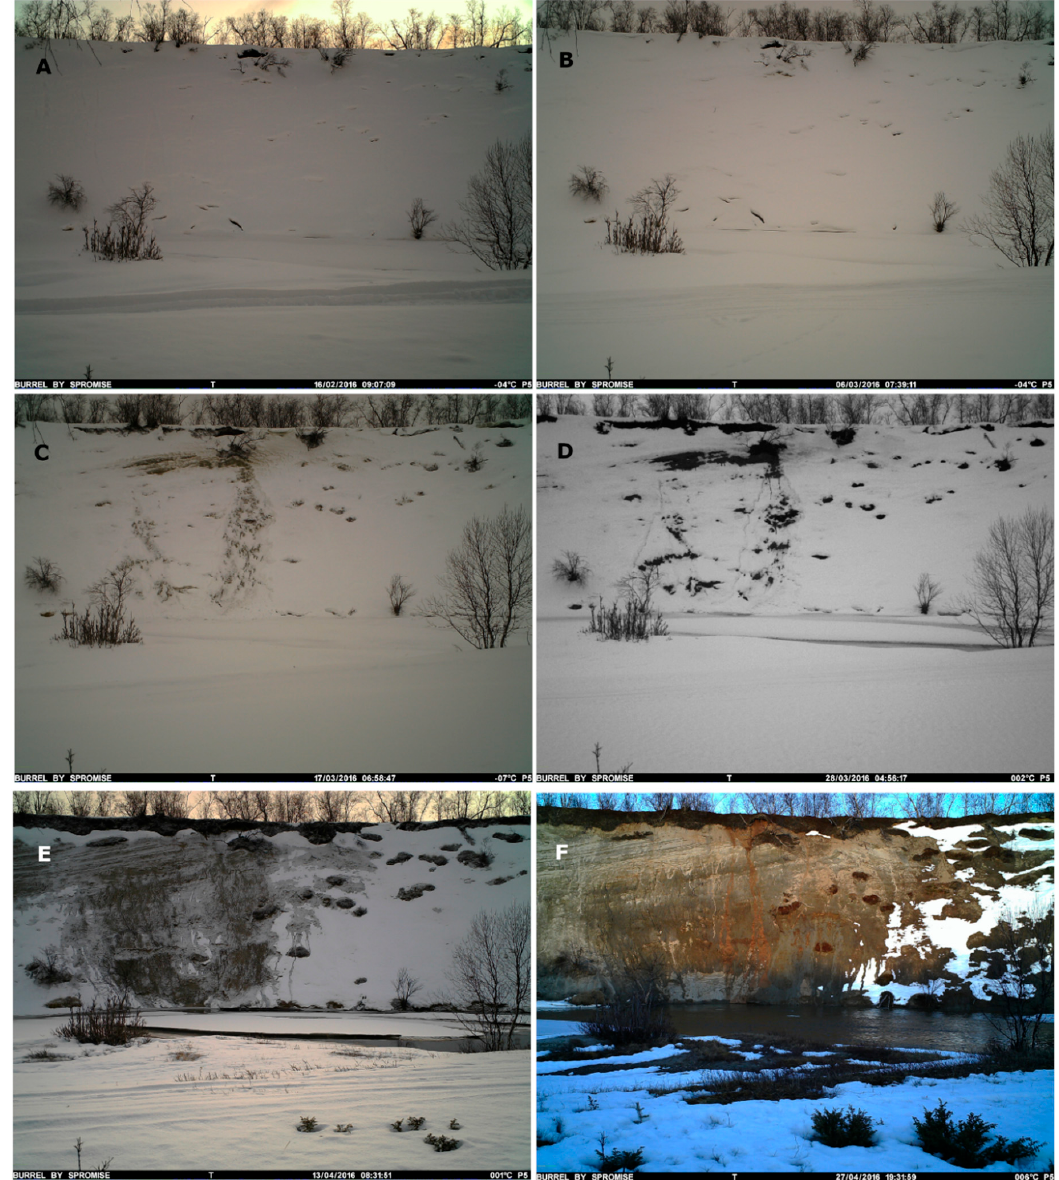
Figure 6. The freezing and thawing during spring 2016 as an example of a thermal ice break-up. ( A ) There are small openings in the ice on 16 February 2016, but those still freeze during the end of the February. ( B ) Open strip appears next to the outer bank 6 March 2016. Between 24 February–6 March, there has been static closed ice cover and below 0 temperatures (of camera). ( C ) During the night preceding 17 March 2016, the temperatures have gone down, and the river has frozen again totally. ( D ) Water is on top of the ice, at both sides of the mid-channel bar, on 28 March 2016. After this time step, there is diurnal freezing and thawing, but the ice cover stays rather similar until 9 April 2016, when water clearly starts flowing on top of the ice. ( E ) The ice cover has clearly collapsed at both banks of the river on 13 April 2016. ( F ) 27 April 2016 the river is ice-free.